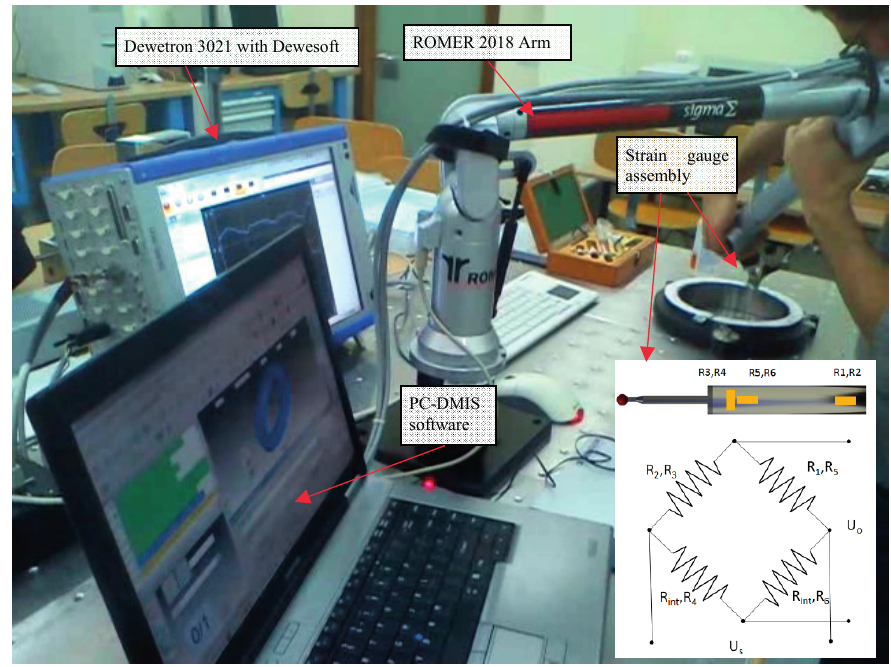
Figure 1. A view of the previous force gauge arrangement measuring a master ring. The configuration of the bridge circuit uses six strain